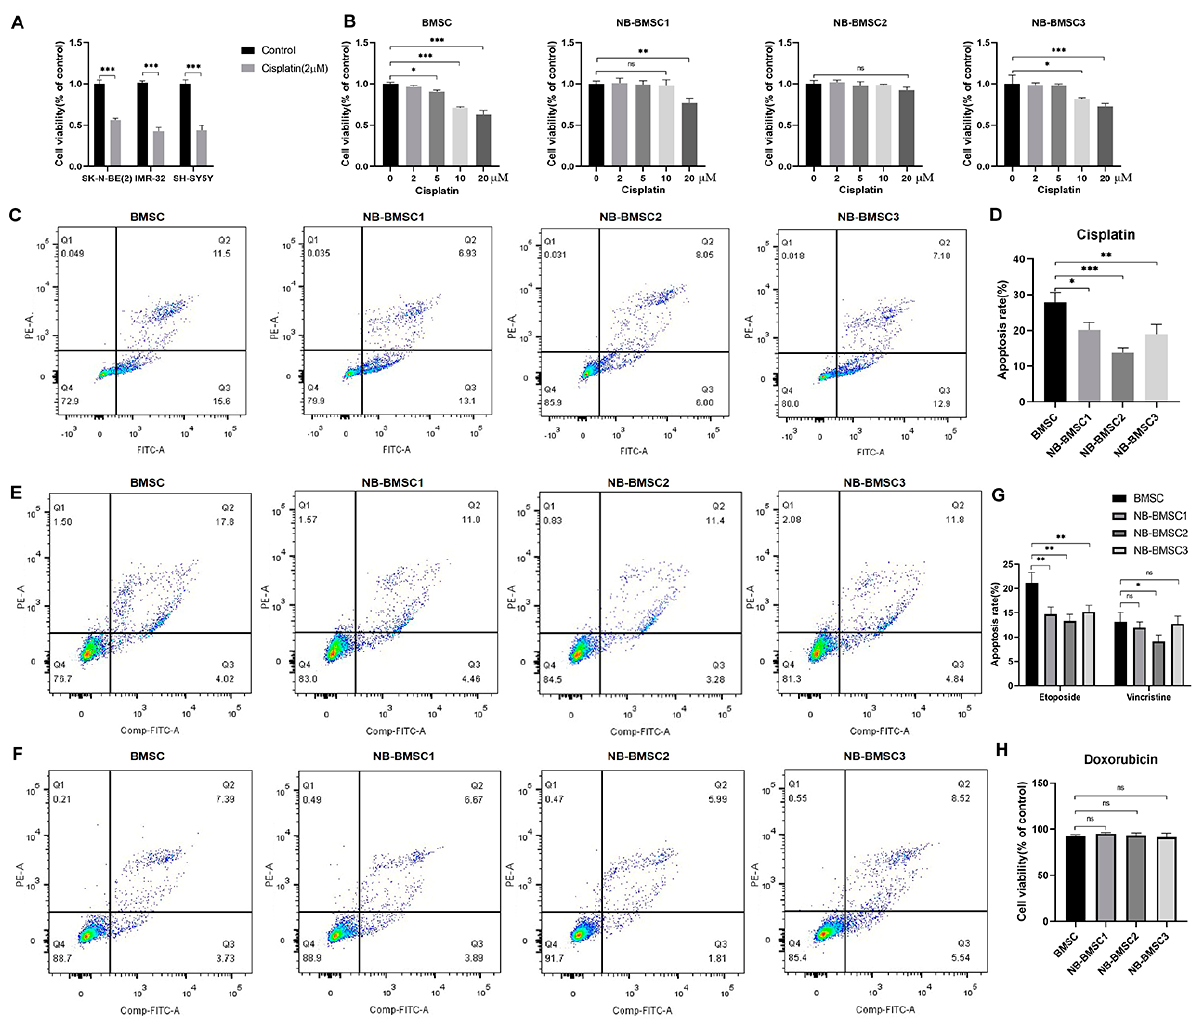
Figure 2. Chemotherapeutic drugs cannot kill NB-BMSCs effectively. ( A ) CCK8 assay was performed to assess NB cell viability under 2 μ M cisplatin. (Student’s t -test was used). ( B ) Cell viability was assessed after 0–20 μ M cisplatin was used to treat BMSCs and NB-BMSCs. ( C , D ) 10 μ M cisplatin was used to assess the anti-cisplatin ability of normal BMSCs and NB-BMSCs. ( E – G ) Apoptosis rate of normal BMSCs and NB-BMSCs was examined under 10 μ M etoposide or vincristine (Most of NB cells were in apoptosis under this concentration). ( H ) Cell viability of normal BMSCs and NB-BMSCs under 20 μ M doxorubicin (NB cells were all in apoptosis under this concentration). A one-way analysis of variance was used. ns not significant; * p < 0.05; ** p < 0.01; *** p < 0.001.